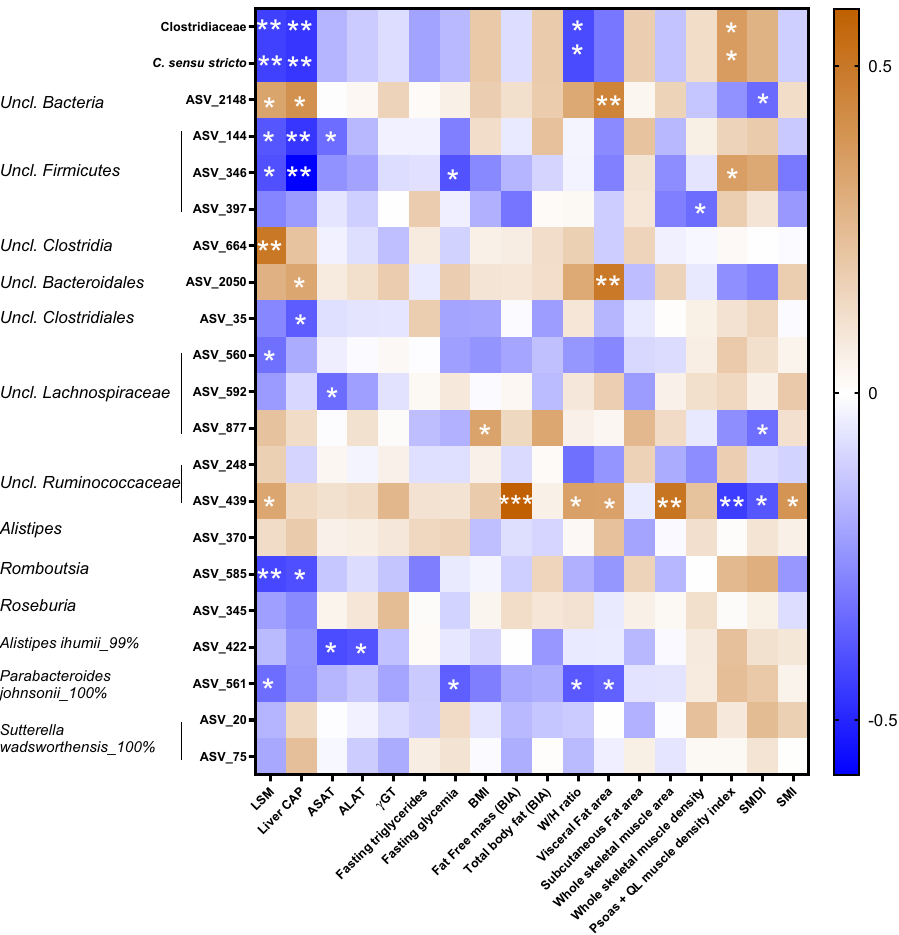
Figure 3. Correlations between taxa or ASV regulated in patients with high-severity of liver steatosis and/ or liver fibrosis and metabolic features. Heatmap of Spearman’s correlations between taxa or ASV significantly different between LS, HS or HS + Fib patients and the most significant differences observed in metabolic outcomes. * p < 0.05, ** p < 0.01 and *** p < 0.001 for significant correlations between parameters. Uncl., unclassified; LSM, liver stiffness measurement; CAP, controlled attenuation parameter; ASAT, aspartate aminotransferase; ALAT, alanine aminotransferase; γGT, γ-glutamyl transferase; BMI, body mass index; W/H ratio, waist to hip ratio; QL, quadratus lumborum muscle; SMDI, skeletal muscle density index; SMI, skeletal muscle index. Heatmap representation was performed using Graphpad Prism software version 8 (www.graph